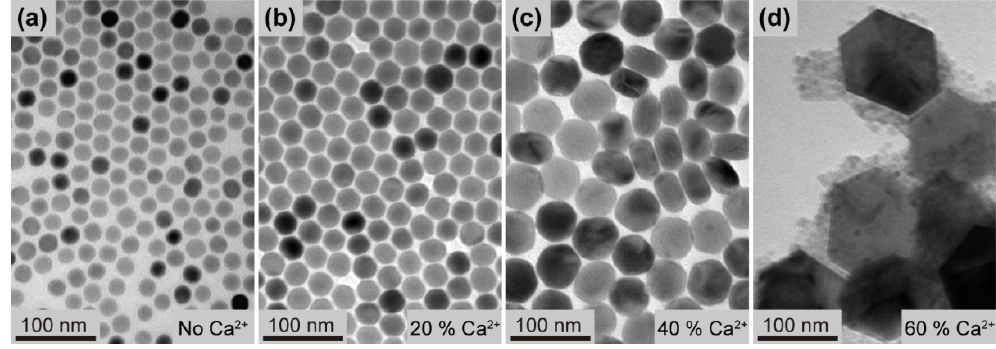
:Yb/Er (18/2 mol %) nanoparticles obtained in the Figure 5. TEM images of the NaYF 4 presence of ( a ) 0 mol %, ( b ) 20 mol %, ( c ) 40 mol %, and ( d ) 60 mol % of Ca 2+ dopant ions,